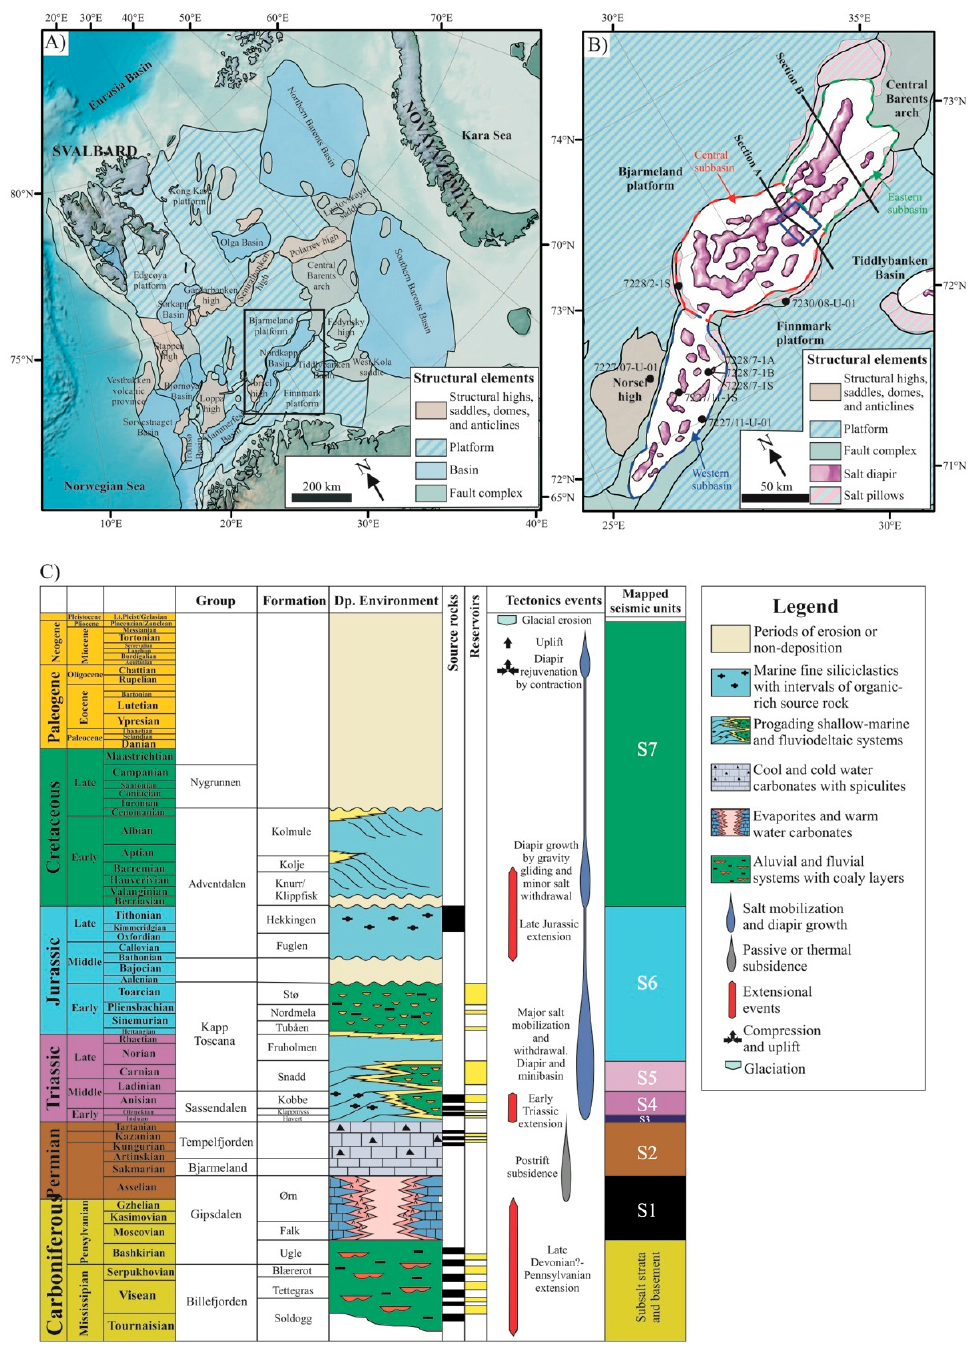
Figure 1. ( A ) Main structural elements of the Barents Sea. The Nordkapp Basin is indicated by the black rectangle. ( B ) Main structural elements of the Nordkapp Basin (modified from Rojo et al. [18]. The basin is divided in three sub-basins: western, central and eastern sub-basins. Black dots are exploration and shallow stratigraphic wells, whereas black lines show the location of the studied sections through the central (section A ) and eastern (section B ) sub-basins. ( C ). A chronostratigraphic chart illustrating the main stratigraphic units, depositional environments, tectonic events, and mapped seismic units of the Barents Sea and Nordkapp Basin (based on [17,18]).